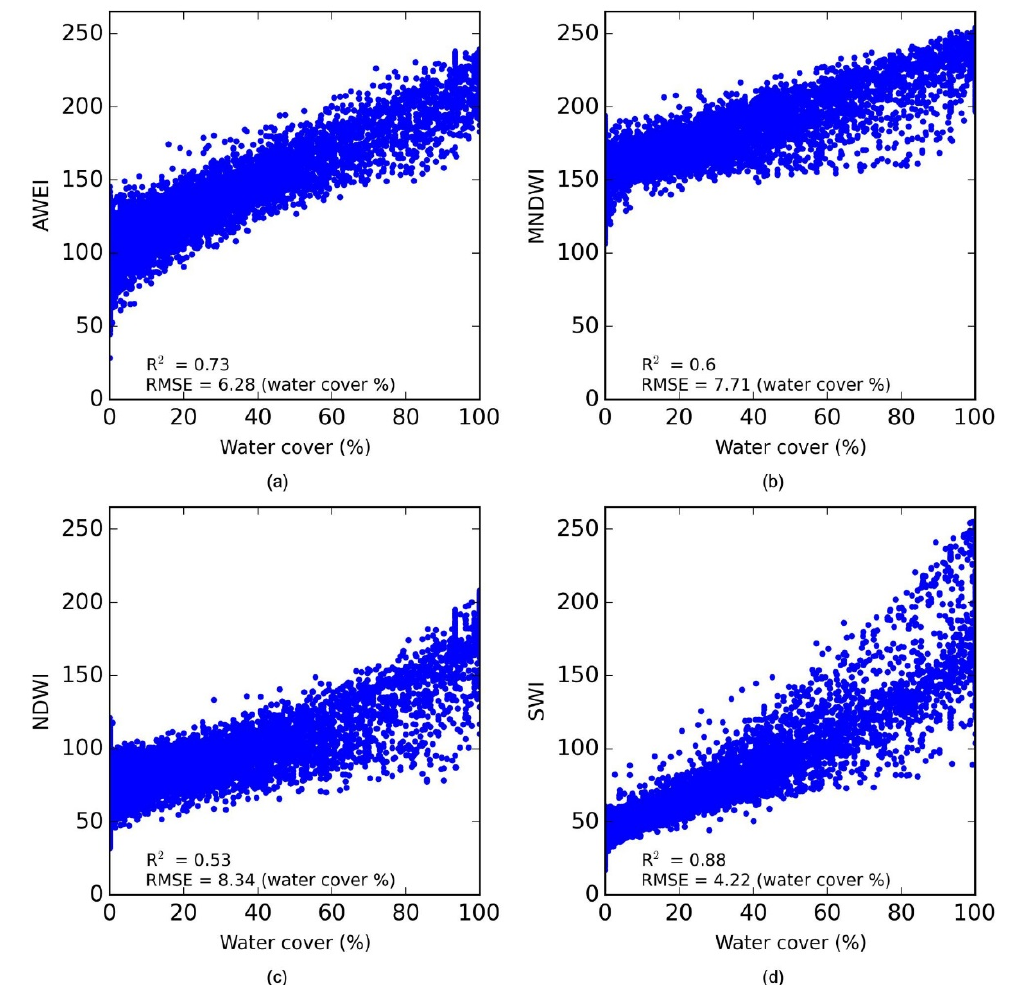
Figure 10. The sensitivity of different water indices to the water cover in a wet region: ( a ) Automated Water Extraction Index (AWEI) vs. water cover, ( b ) Modified Normalized Difference Water Index (MNDWI) vs. water cover, ( c ) Normalized Difference Water Index (NDWI) vs. water cover, ( d ) Superfine Water Index (SWI) vs. water cover. The monthly variation of the green, near infrared, saturation, and SWI values over the water and non-water areas in a wet region is shown in Figure 11. Due to the presence of dense vegetation, the green reflectance is not very sensitive to the water cover. However, the near infrared reflectance is showing high contrast between the water and non-water areas. Similar to the green reflectance, the saturation from the visible wavelength regions is also not very sensitive to the water cover. However, for water areas, the saturation values are higher than the near infrared reflectance as in the snowy and dry regions. For non-water areas, when the near infrared reflectance is uplifted by introducing the coefficient to it, high contrast with the saturation values was obtained. In this research, the coefficient of 7.0 was used so that the raised near infrared reflectance by this level did not interfere with the saturation values of the water areas everywhere in the globe. Therefore, the SWI has worked very well for discriminating the water areas in all